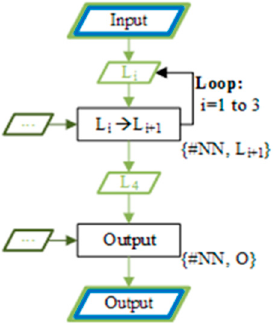
Figure 7. Flow chart of the fundamental NN inference approach on GPU.